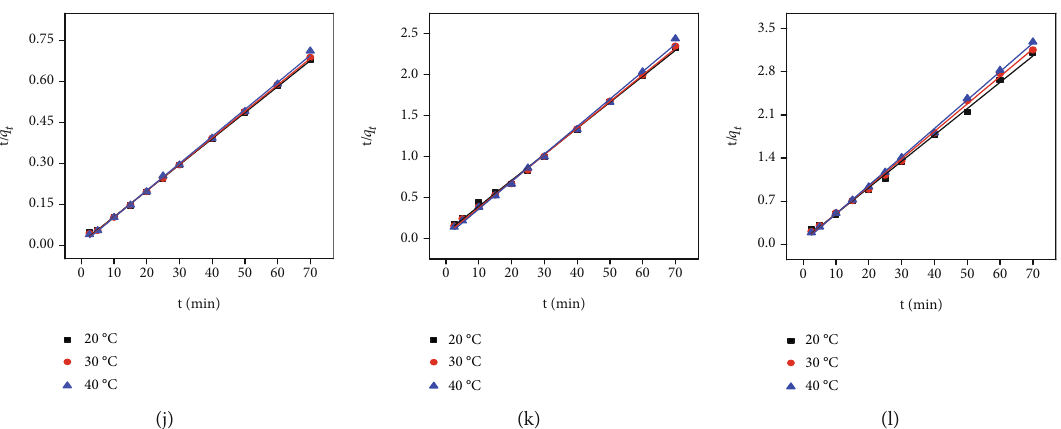
Figure 2: Langmuir (a – c), Freundlich (d – f), Dubinin – Radushkevich (g – i) isotherms, and pseudo-second-order kinetics (j – l) model of Pb 2+ , Cd 2+ , and Ni 2+ adsorption on EPS.